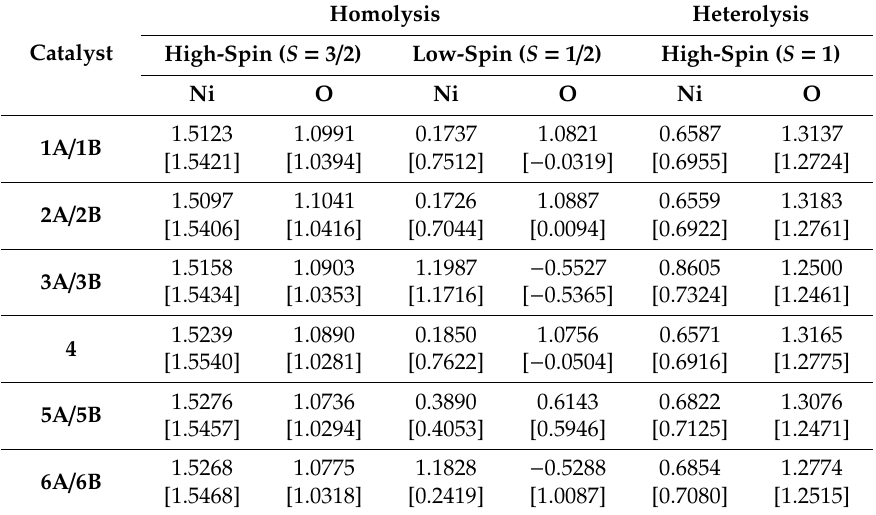
Table 5. Mulliken spin population of Ni and O axial in the three possible active nickel-oxo intermediates calculated both in the gas phase and in solution. Values enclosed in brackets refer to solvated structures. Heterolytic cleavage of the O–O bond only led to high-spin triplet